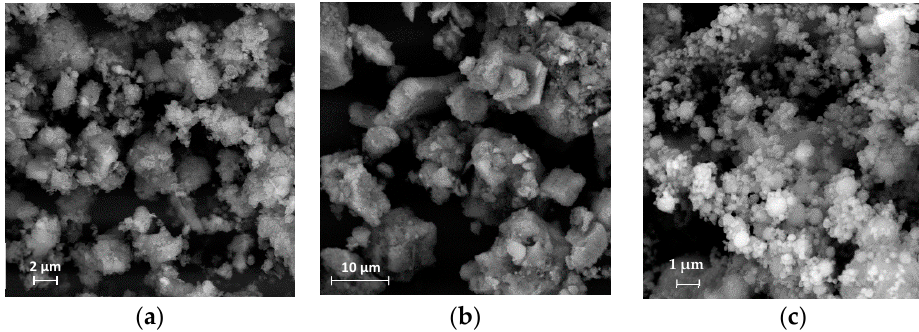
Figure 3. SEM images of RM ( a ), GGBFS ( b ), and EAFD ( c ).